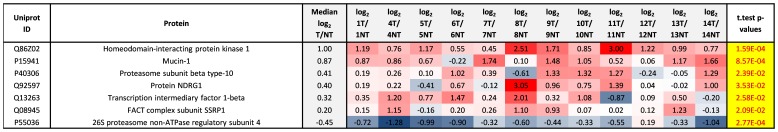
Significantly modulated DNA damage and repair proteins.All proteins in this figure were associated with the GO terms ‘DNA damage’ & ‘DNA repair’, and also shown to be significantly (p≤0.05) up- or down- regulated in tumor compared to non-tumor tissue and quantifiable in each case (e.g. all proteins containing NA for any case were excluded from the table). Log2 T/NT ratios of the non-phosphorylated peptides from each protein were used as surrogates to calculate the relative abundance of the respective proteins. Log2 T/NT ratios of the non-phosphorylated peptides were averaged over three arms of the workflow (IMAC, TiO2, Non-enrich).